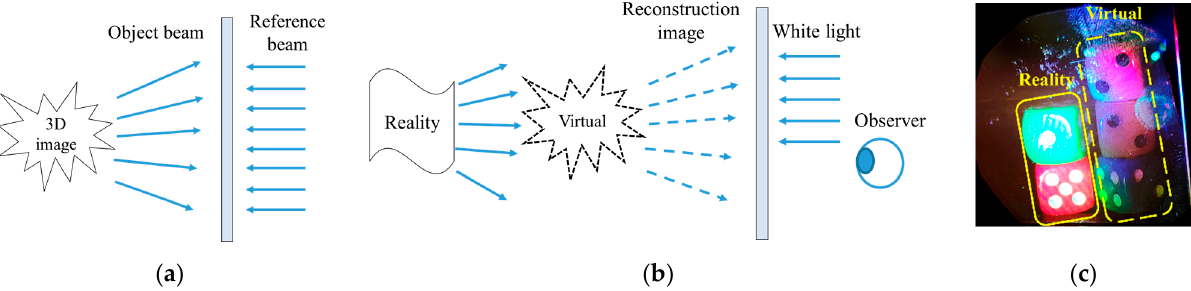
Figure 11. Recording and reconstruction procedure of volume holography: ( a ) volume holographic recording; ( b ) volume holographic reconstruction; ( c ) virtual and reality superposition .